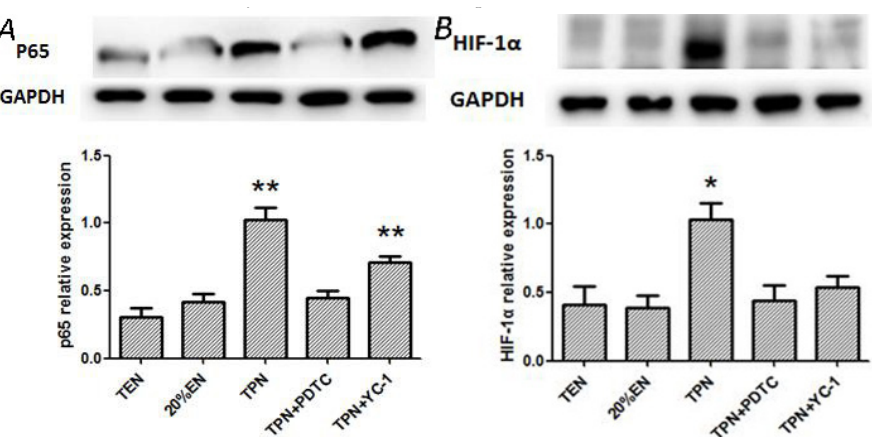
Figure 7. ( A ) Western blotting analysis of NF- κ B-P65 in the intestine mucosa; ( B ) Western blotting analysis of HIF-1 α in the intestine mucosa. We found a distinct upregulation of p65 in both TPN and TPN+YC-1 groups ( p = 0.004 and 0.008 compared with TEN group). For HIF-1 α expression, a significant increase was only found in the TPN group ( p = 0.029 compared with TEN). * p < 0.05, compared with TEN group. ** p < 0.01, compared with TEN